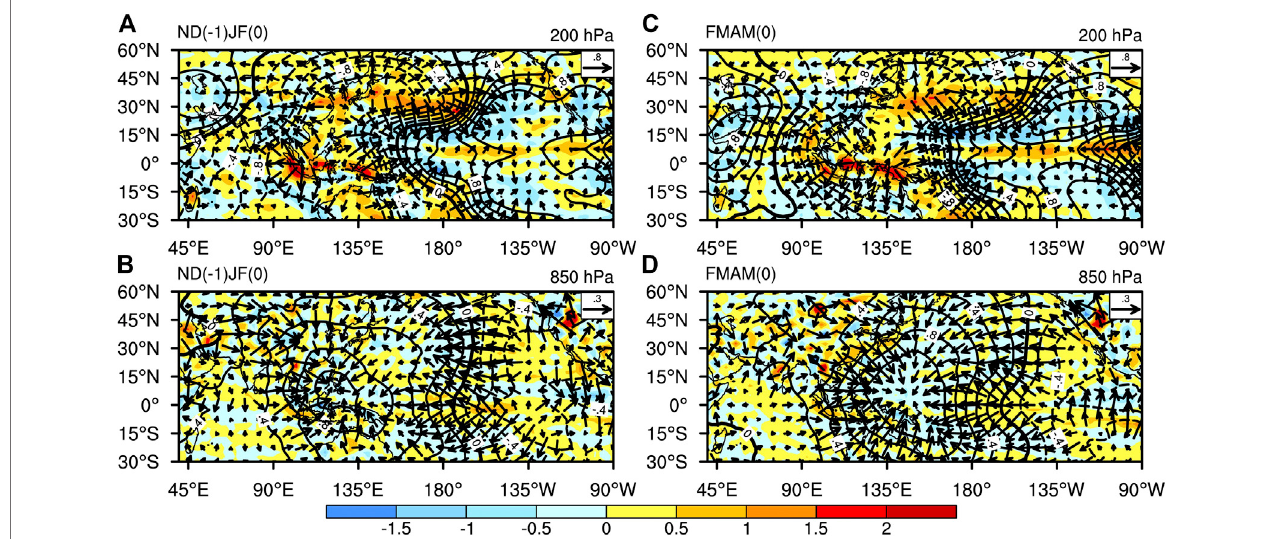
FIGURE 11 | (A) Epochal differences of divergent wind (arrows, m/s), divergence (shading, 10 – 6 /s) and velocity potential function (contours, 106 m 2 /s) at 200 hPa and for November – February. (B) Same as (A) , but at 850 hPa and for November – February. (C) Same as (A) , but for February – May. (D) Same as (B) , but for February – May. “ (1) ” denotes (1993 – 2016) minus (1979 – 1992), and “ (0) ” denotes (1994 – 2017) minus (1980 –